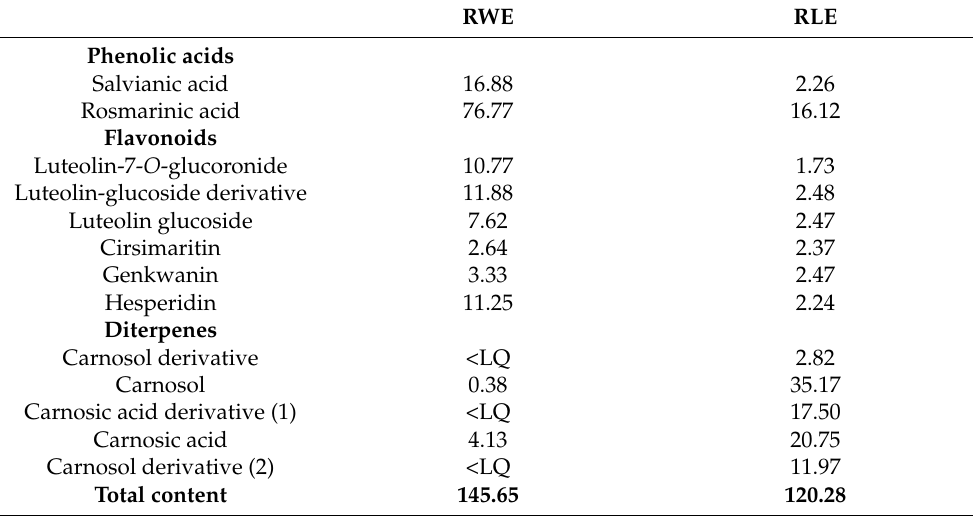
Table 1. Polyphenol content (mg/g) of rosemary